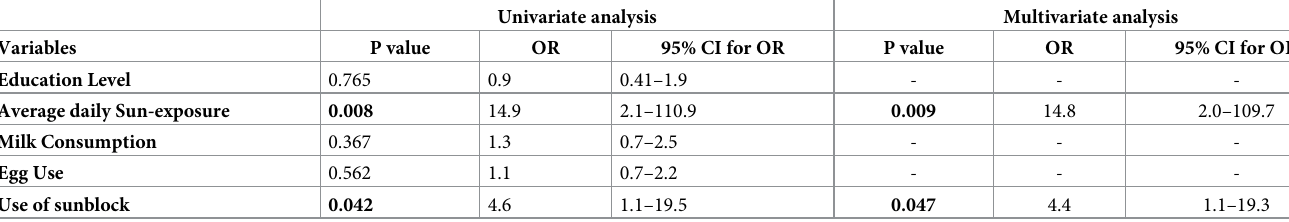
Table 6. Risk factors for vitamin D insufficiency by regression